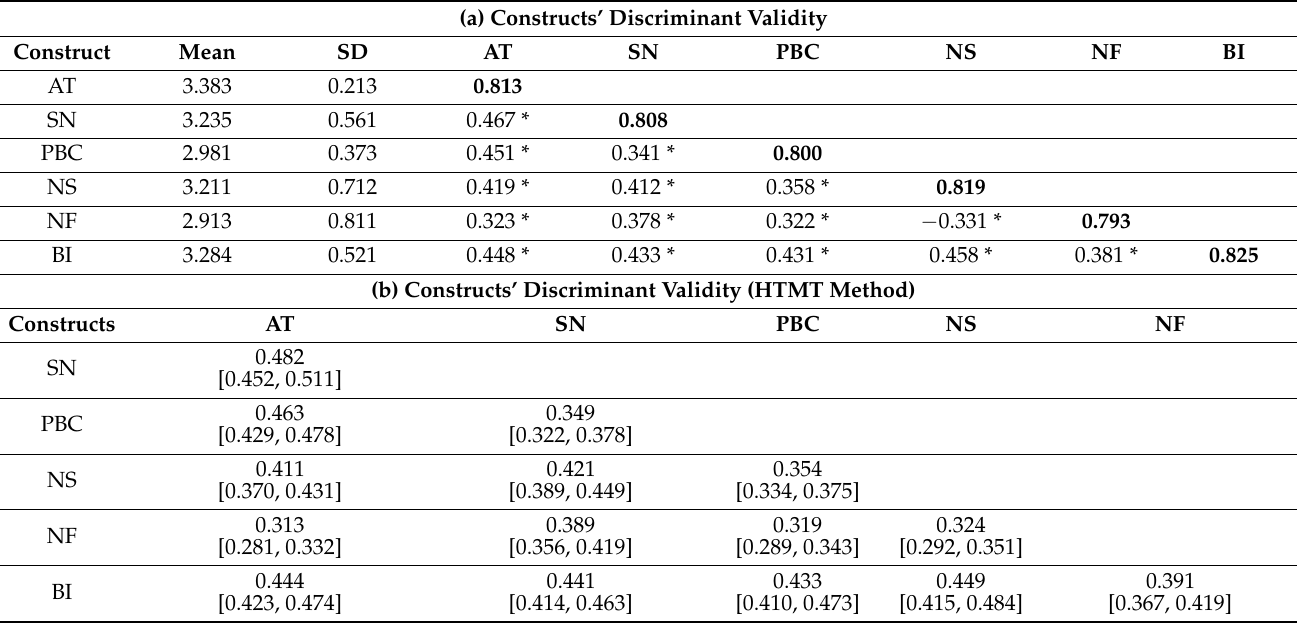
Table 3. (a) Constructs’ discriminant validity. (b) Constructs’ discriminant validity (HTMT method). (a) Constructs’ Discriminant Validity